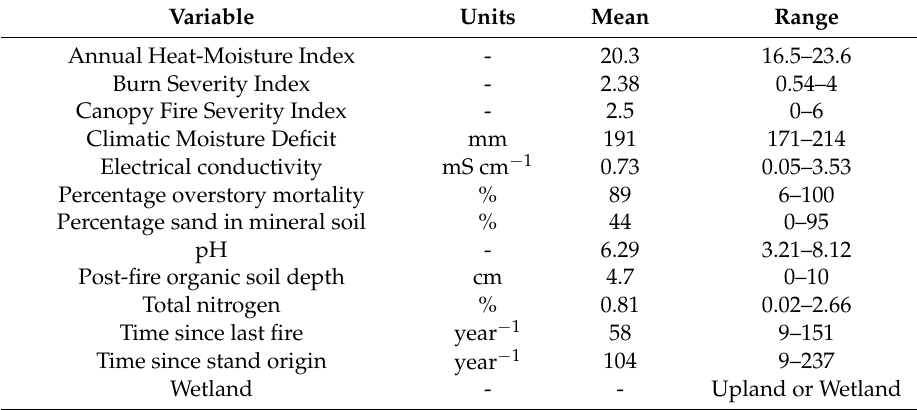
Table 3. Environmental, climate, burn severity, and fire history variables included in the classification and regression tree models of the dominance shifts of tree species. Unitless variables are identified with a hyphen in the Units